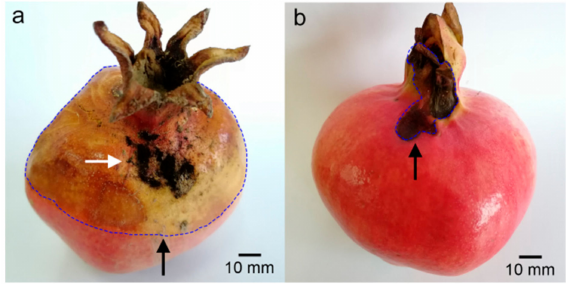
Figure 1. Symptoms of soft rot ( a ) and dry rot ( b ) in pomegranate under natural conditions.